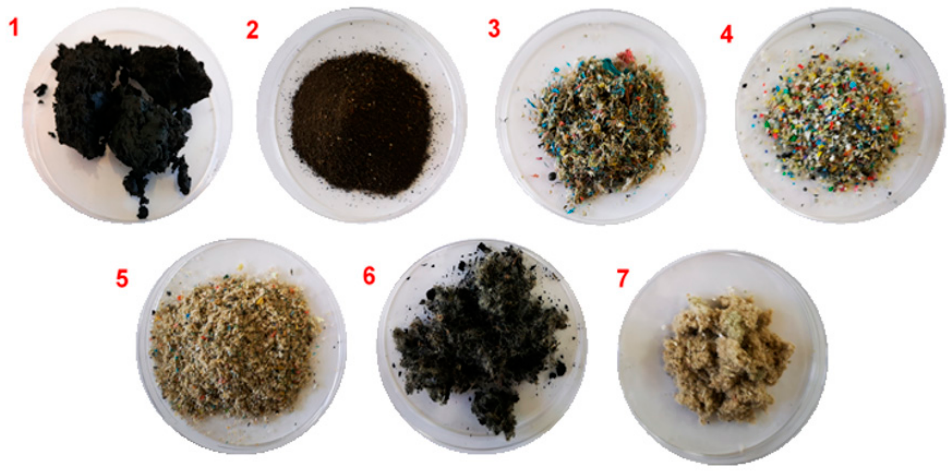
Figure 2. Consistency of 1—raw SS (moisture 72 wt. %) and visualization of waste inputs: